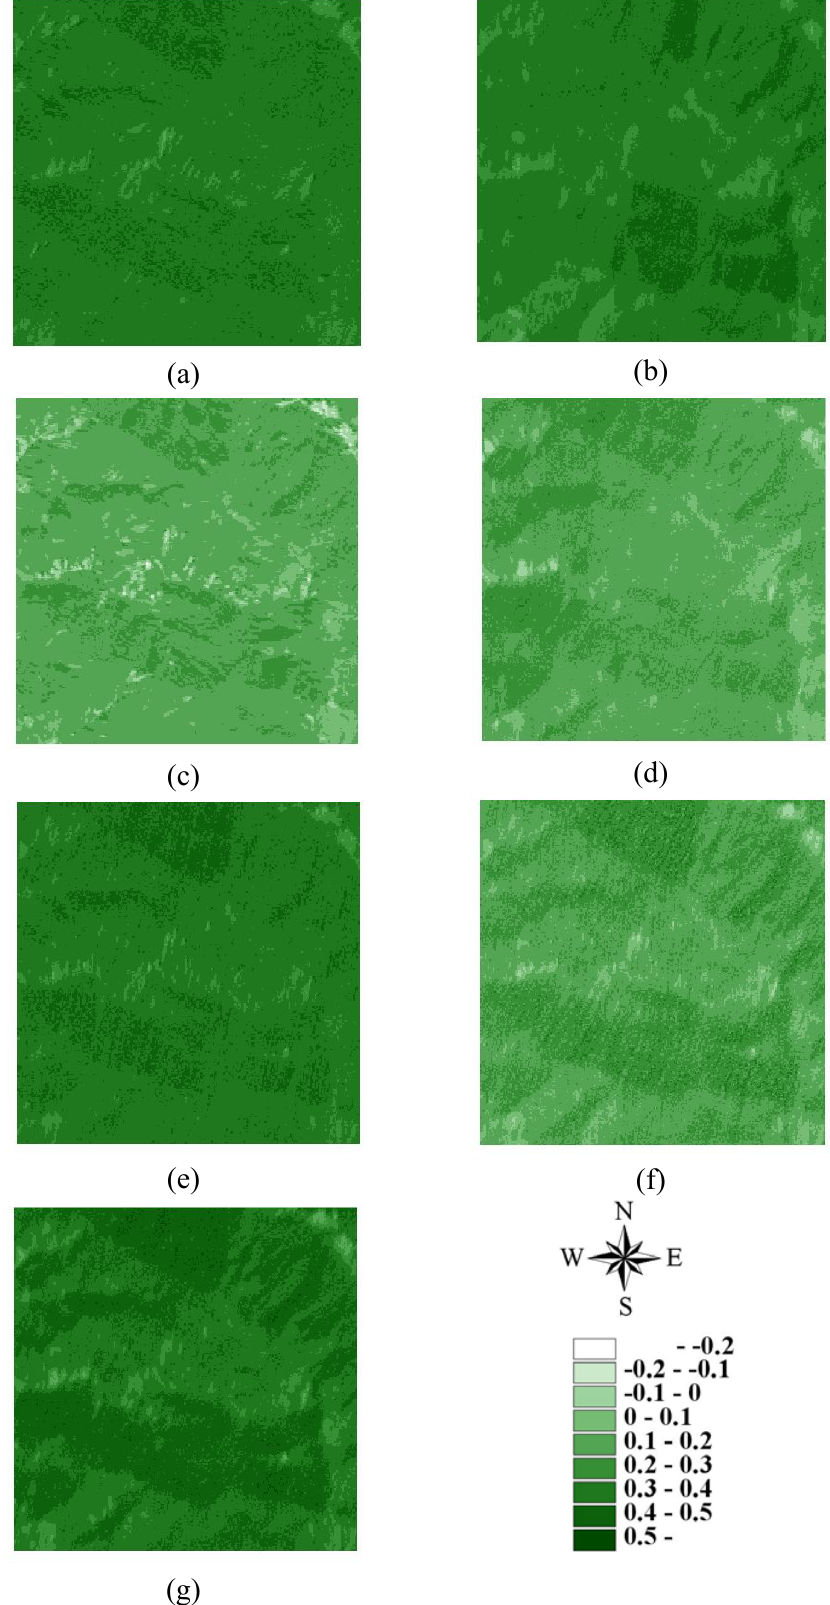
Figure 2. NDVI images of area A on (a) 1996/11/08, (b) 1999/03/06, (c) 1999/10/31, (d) 2000/11/27, (e) 2001/11/20, (f) 2003/12/17, and (g)